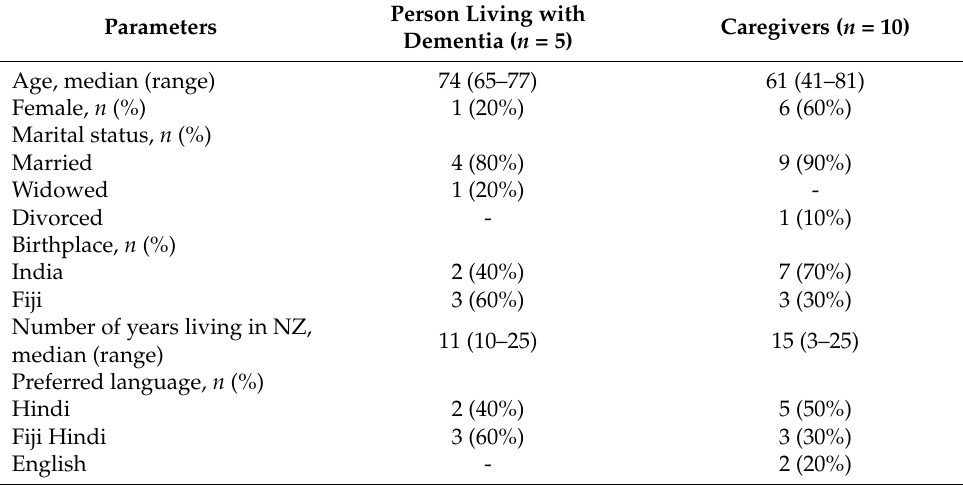
Table 1. Demographic details of the person living with dementia and caregivers.